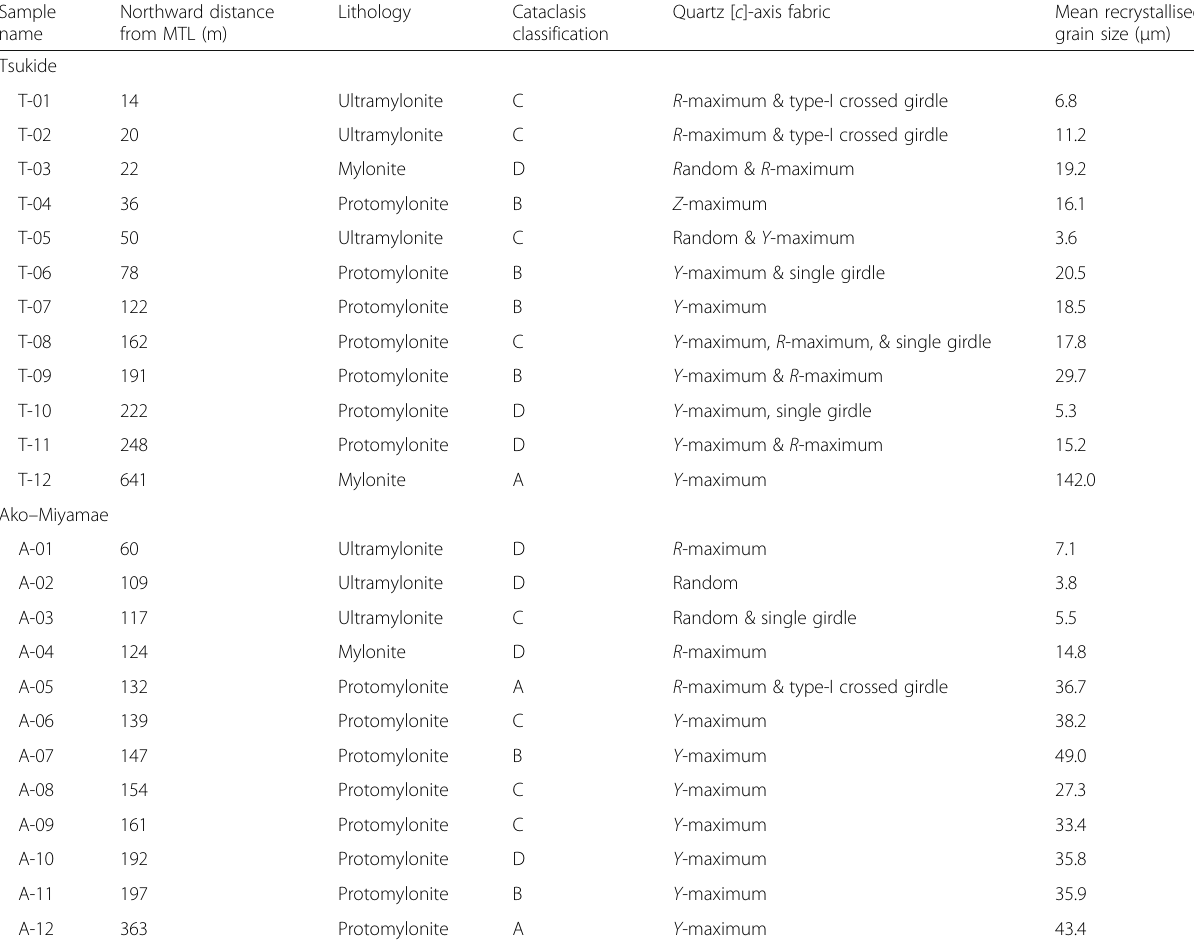
Table 1 Summary of Ryoke mylonite samples analysed by EBSD and their measured quartz LPO and recrystallised grain size Sample